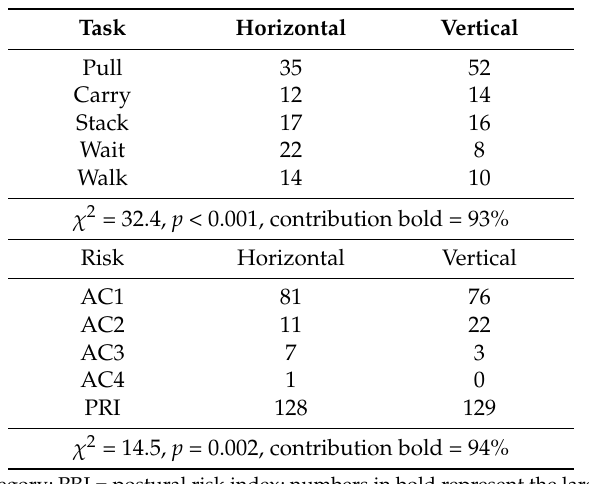
Table 6. Percent distribution of observed frames among task types (above) and postural risk classes (below) at the unloading station, for two stacking techniques: horizontal and vertical ( n =